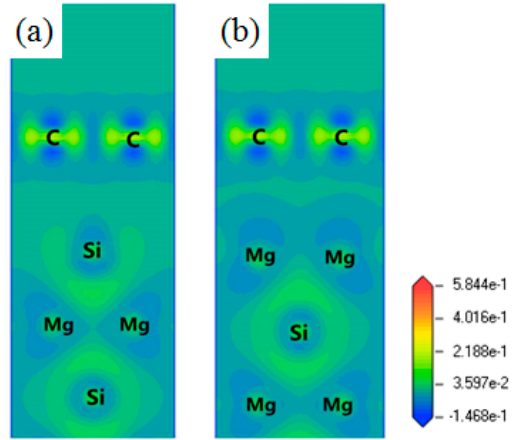
Figure 7. The charge density difference diagram for Mg 2 Si (011)/Gr (0001) interfaces: ( a ) Si-center- sited; ( b ) Mg-center-sited.